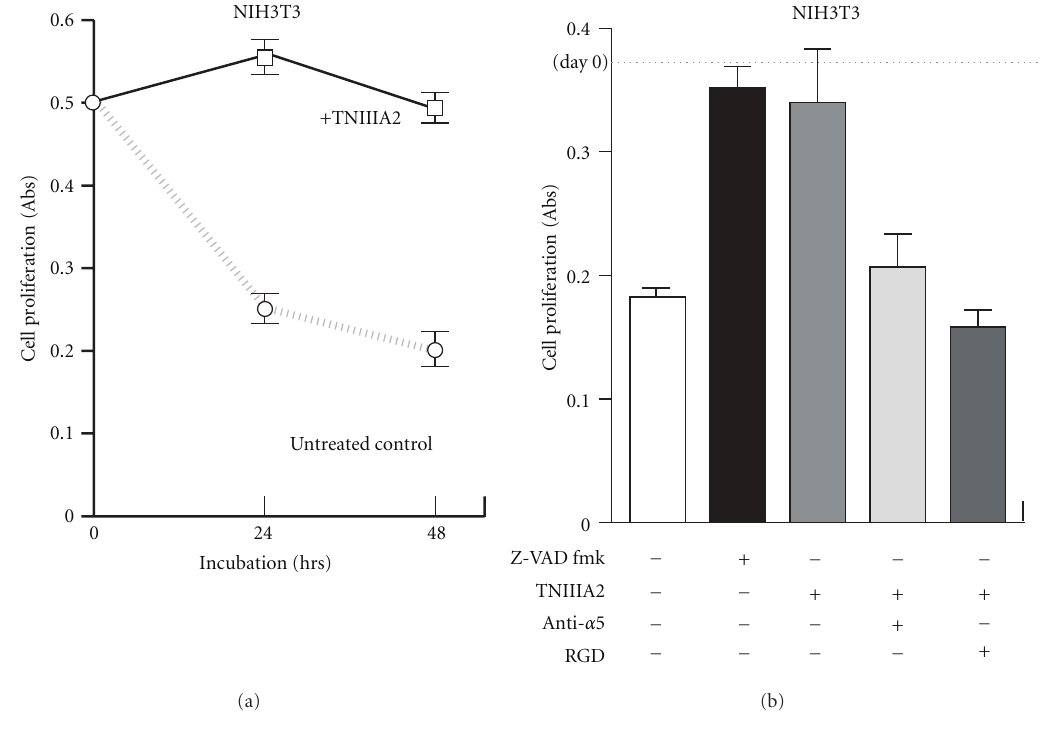
Figure 6: TNIIIA2 protects cells from anoikis by activating the β 1-integrin. (a) Time-course study of the e ff ect of cell-detachment in survival/proliferation of NIH3T3 cells. (b) E ff ect of inhibition of apoptosis (Z-VAD) or α 5 β 1 integrin signal (anti- α 5 Ab and RGD peptide) in detachment-induced cell death (our unpublished